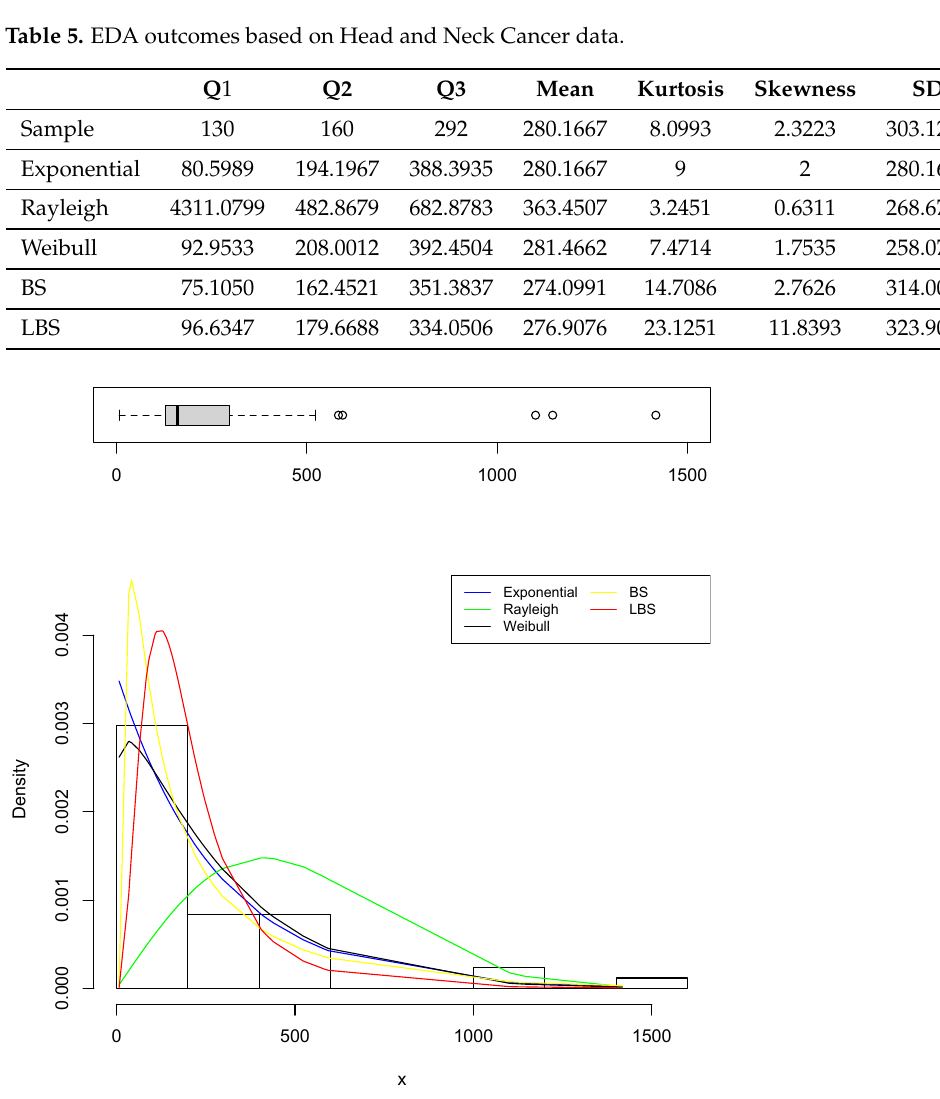
Figure 9. The fitted PDFs based on Head and Neck Cancer